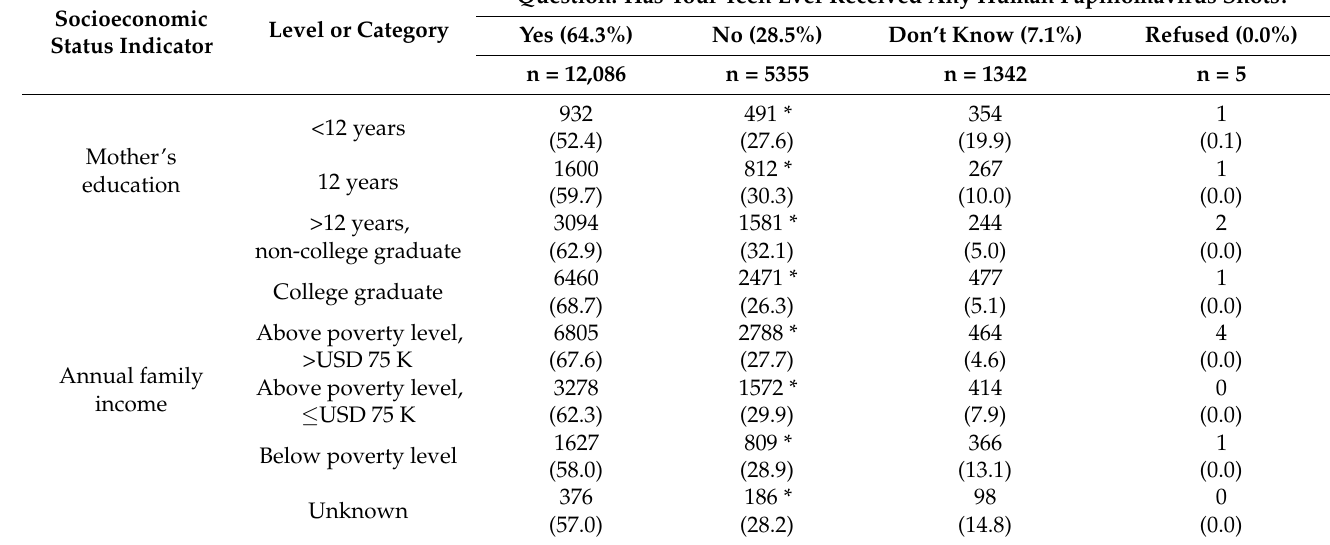
Table 4. The proportion of HPV-unvaccinated teens with the parent-reported vaccination